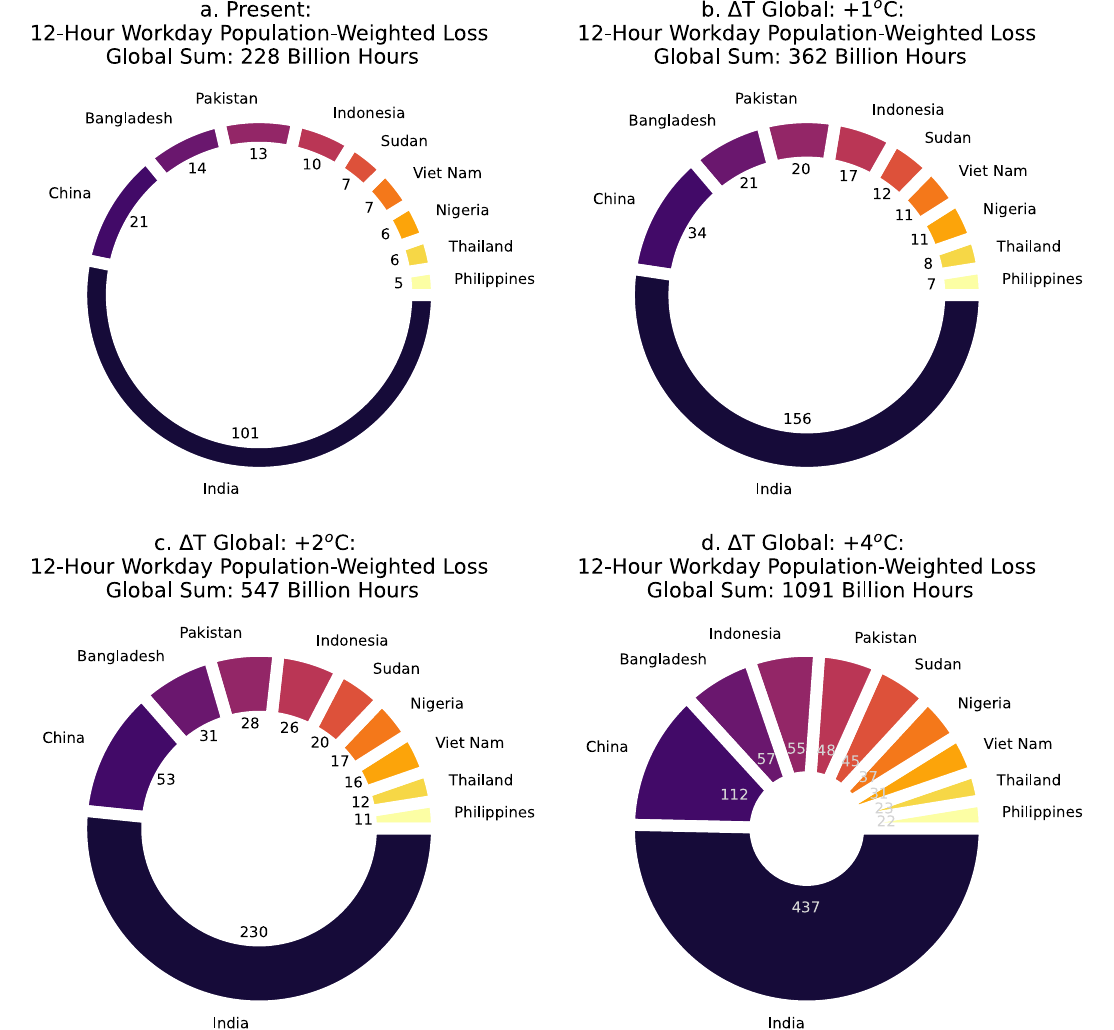
Fig. 6 Countries with the most population-weighted labor losses from heat exposure. The ten countries with the most heavy labor losses in the 12-h workday due to heat exposure weighted by the working-age population in outdoor heavy labor industries in the present ( a 2001 – 2020 mean), and with + 1 °C, + 2 °C, and + 4 °C of additional global warming ( b – d , Global Δ T ). The global sum of labor lost (sum of 163 countries with available data; Supplementary Table 1) is shown above each plot, the numbers around the center of the circle show individual losses per country, and the thickness of the circle increases as the global sum of labor lost increases with warming (details in “ Methods ” ). All units are in billions of